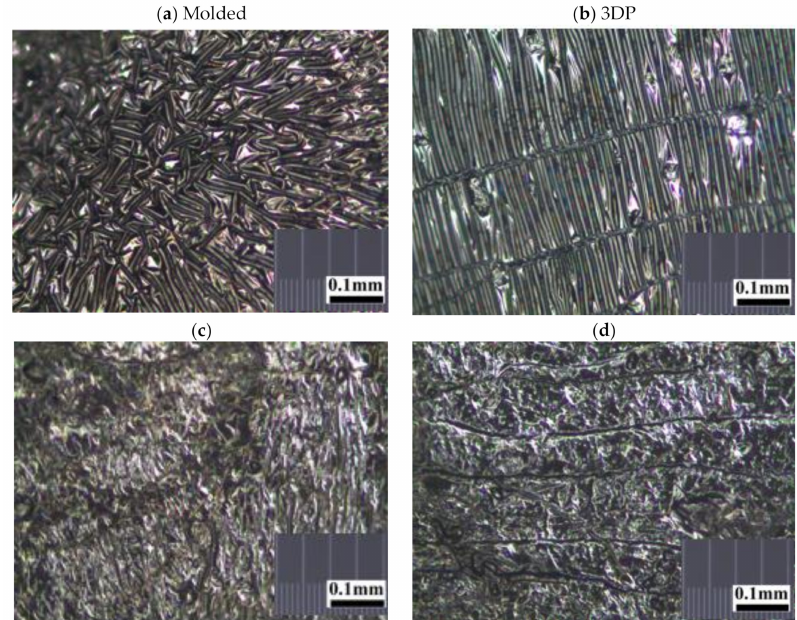
Figure 5. Representative stereomicroscopic images of the core surfaces of silicone meniscus implants. ( a ) surface of molded implant, ( b ) surface of 3D printed implant, ( c ) cross-section of molded implant and ( d ) cross-section of 3D printed implant (20 ×